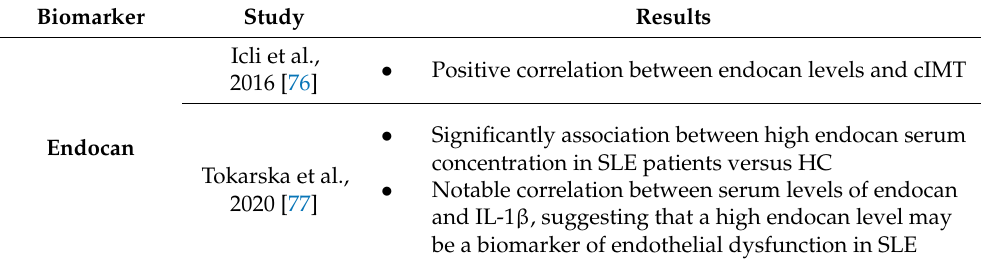
Table 3. Endocan in SLE cases.